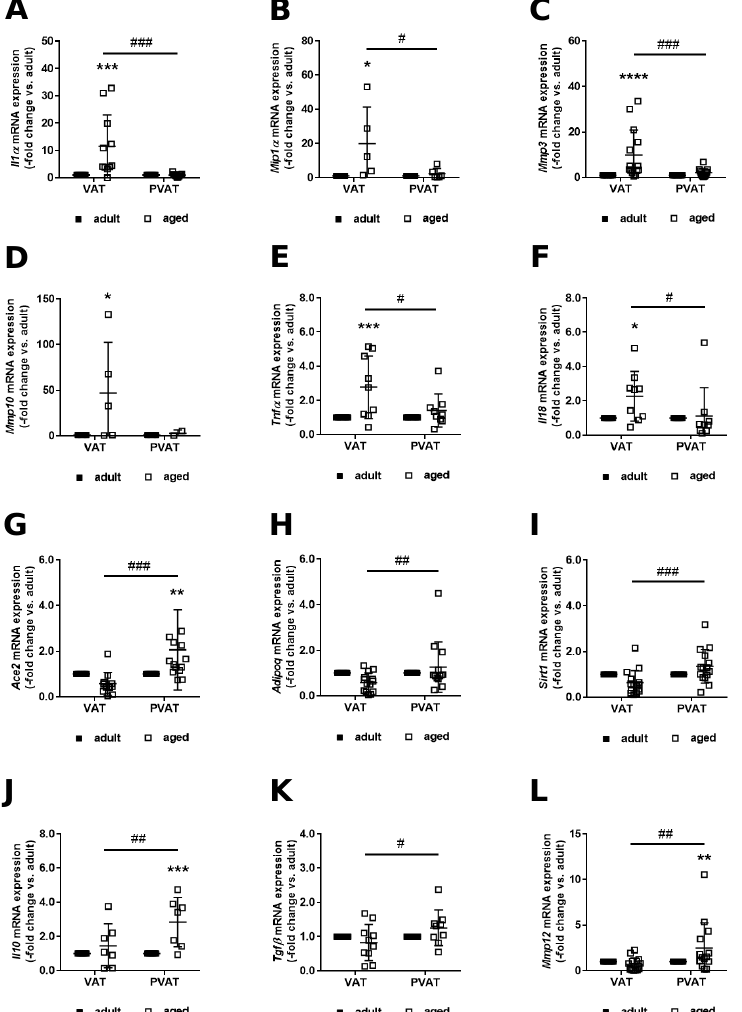
Figure 4. Di ff erential e ff ects of age on adipose tissue gene expression patterns. Visceral (VAT) and perivascular (PVAT) adipose tissues were harvested from adult ( n = 5–16) and aged ( n = 5–16) mice and total RNA isolated. Real-time PCR analysis was employed to quantify the mRNA expression of ( A ) interleukin-1alpha (Il1 α ), ( B ) macrophage inflammatory protein 1-alpha (Mip1 α ), ( C ) matrix metalloproteinase-3 (Mmp3), ( D ) Mmp10, ( E ) tumor necrosis factor-alpha (Tnf α ), ( F ) Il18, ( G ) angiotensin-converting enzyme-2 (Ace2), ( H ) adiponectin (Adipoq), ( I ) sirtuin-1 (Sirt1), ( J ) Il10, ( K ) transforming growth factor-beta (Tgf β ), and ( L ) Mmp12. Individual data points and the mean ± SD are shown. * p < 0.05, ** p < 0.01, *** p < 0.001 and **** p < 0.0001 vs. adult mice and # p < 0.05, ## p < 0.01 and ### p < 0.001 vs. VAT (as determined by two-way